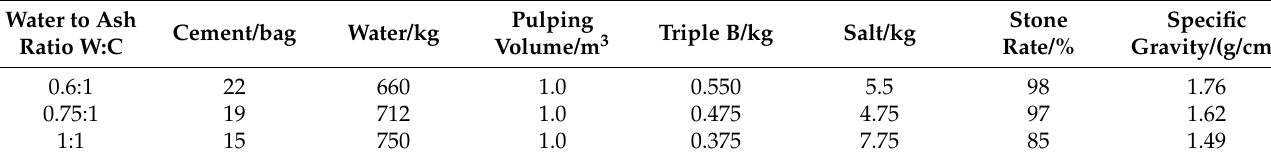
Table 2. Single cement slurry formulation